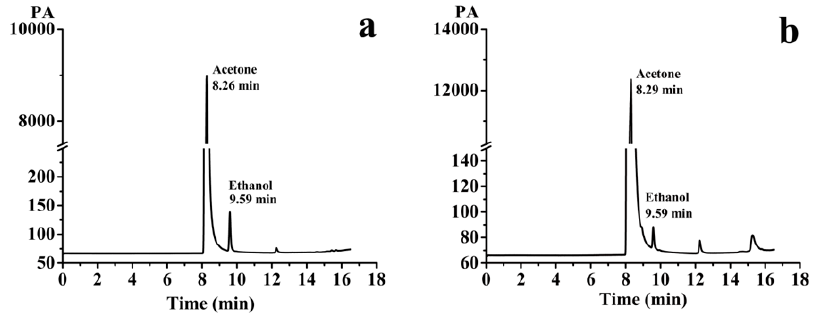
Figure 7. ( a ) Gas chromatograms of ethanol standard solution; ( b ) The gas phase of the 100 mg/mL acetone solution of HK–PLX (1:4) SD.